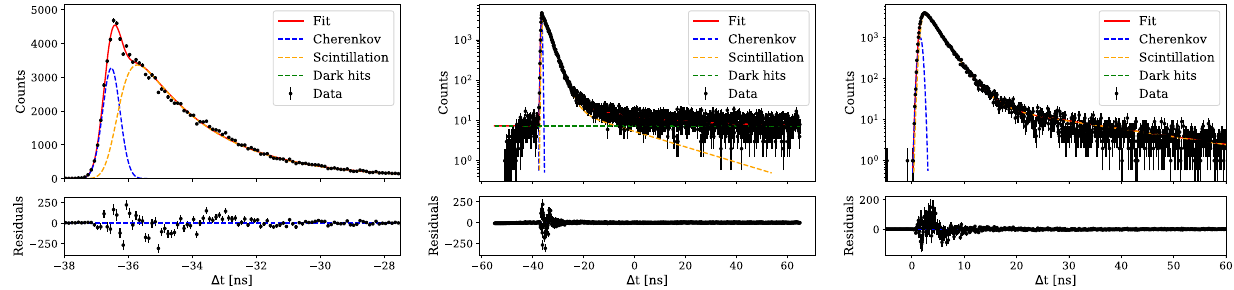
Fig. 10 The best-fit analytic model compared to the 5% WbLS data, for the peak-region of the LAPPD (left), full analysis window of the LAPPD (middle), and full analysis window of the timing PMT (right). The analytical model contains several approximations which are not present in the MC (Fig. 12, center)